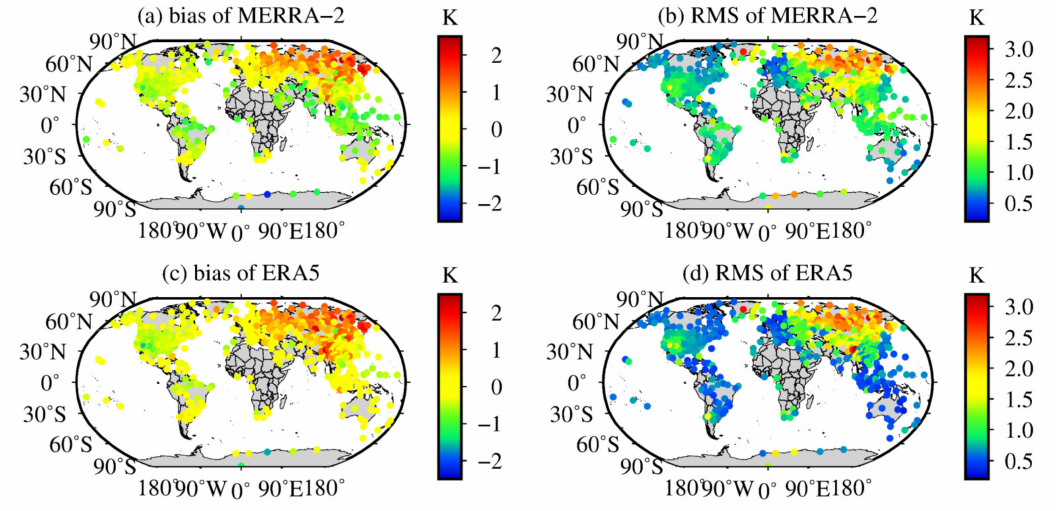
Figure 13. Distributions of the ( a , c ) bias and ( b , d ) RMS of T m values calculated from ERA5 and MERRA-2 pressure-level data with respect to the radiosonde T m from 2016 to